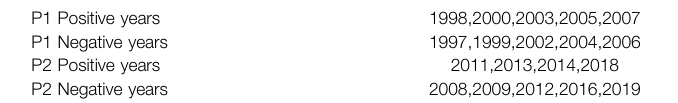
TABLE 1 | Positive and negative years in P1 and P2 identi fi ed by the threshold of zero of the summer rainfall time series after removing the linear trend. P1 Positive